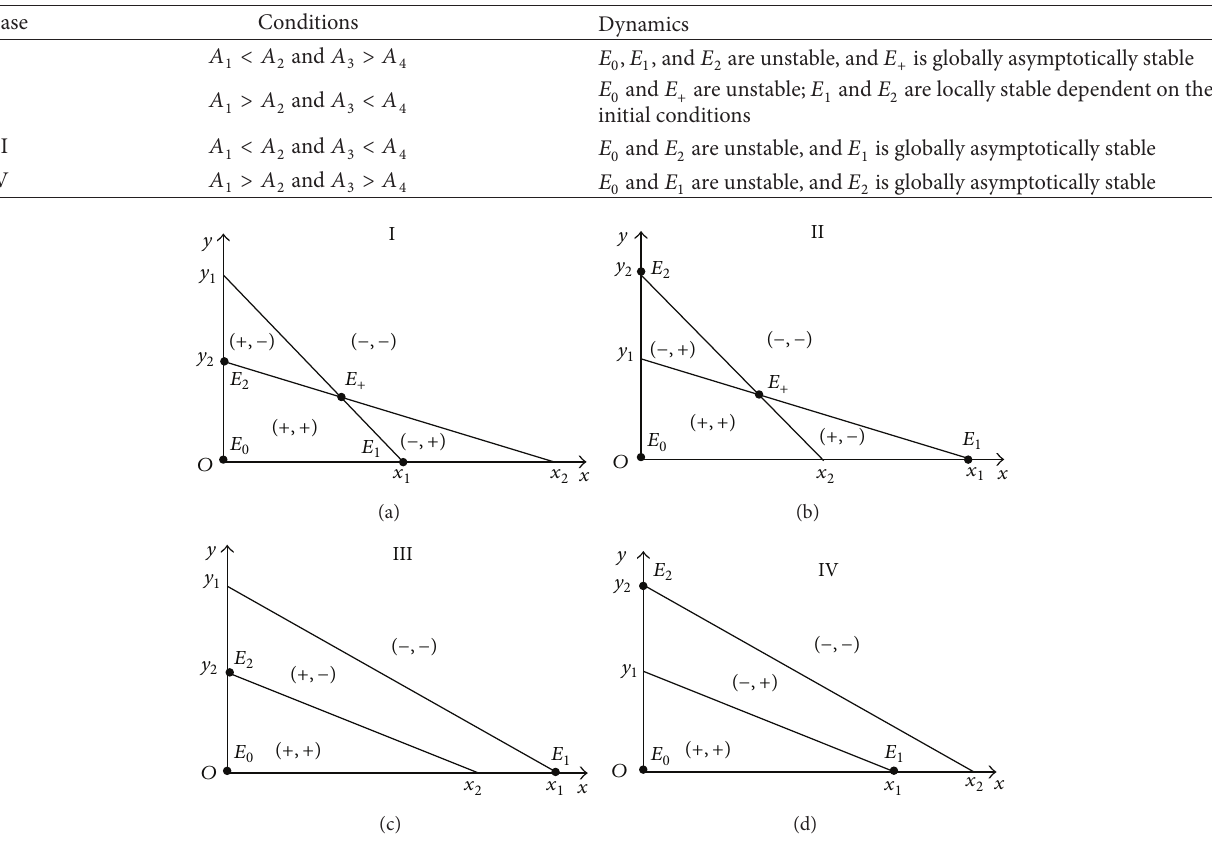
Figure 1: Illustration of the equilibria and the vector field of system (1). (I) 𝐴 1 < 𝐴 2 and 𝐴 3 > 𝐴 4 ; (II) 𝐴 1 > 𝐴 2 and 𝐴 3 < 𝐴 4 ; (III) 𝐴 1 < 𝐴 2 and 𝐴 3 < 𝐴 4 ; (IV) 𝐴 1 > 𝐴 2 and 𝐴 3 > 𝐴 4 . Each equilibrium is represented by a closed cycle ( ∙ ), and the sign of the derivative of 𝑥 , 𝑦 in each subregion is denoted by (𝑎, 𝑏) , where 𝑎 is the sign of the derivative of 𝑥 and 𝑏 is the sign of the derivative of 𝑦 . Note that the expressions of 𝑥 𝑦 𝑦 𝐴 𝐴 𝐴 𝐴 𝑥 1 , 2 , 1 , 2 , 1 , 2 , 3 , and 4 are shown in (4), (6), and